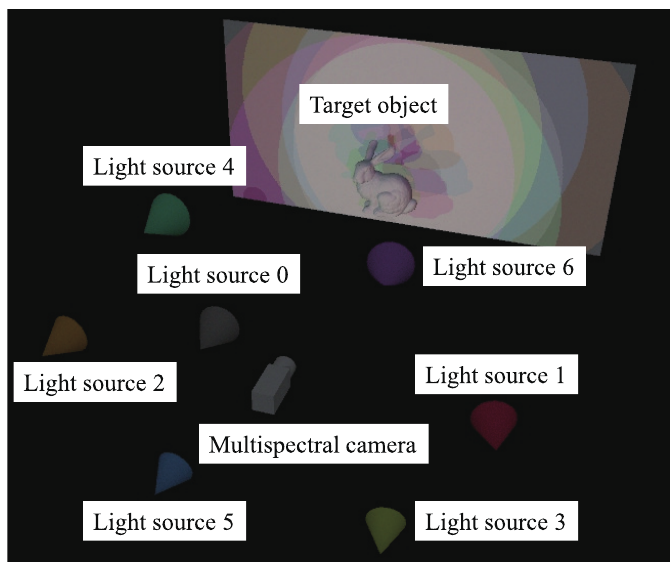
Figure 1. Conceptual explanation of multispectral color photometric stereo. Target object is illuminated by multiple light sources whose wavelengths are different. One image is taken using multispectral